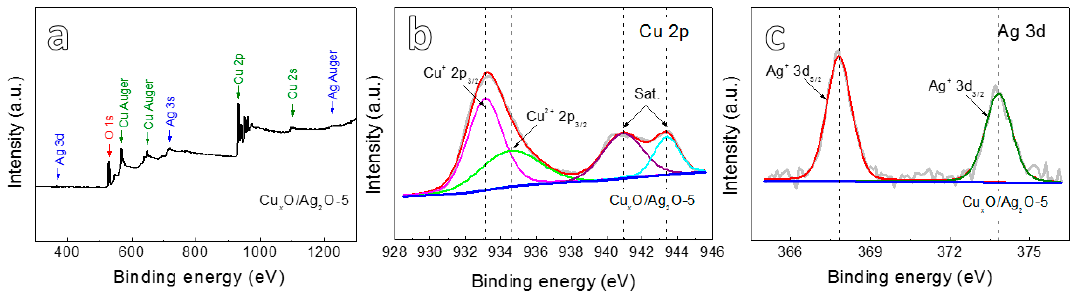
Figure 3. ( a ) XPS spectrum of the Cu x O / Ag 2 O-5; ( b ) Cu 2p XPS spectrum of Cu x O / Ag 2 O-5; ( c ) Ag 3d XPS spectrum of Cu x O / Ag 2 O-5.